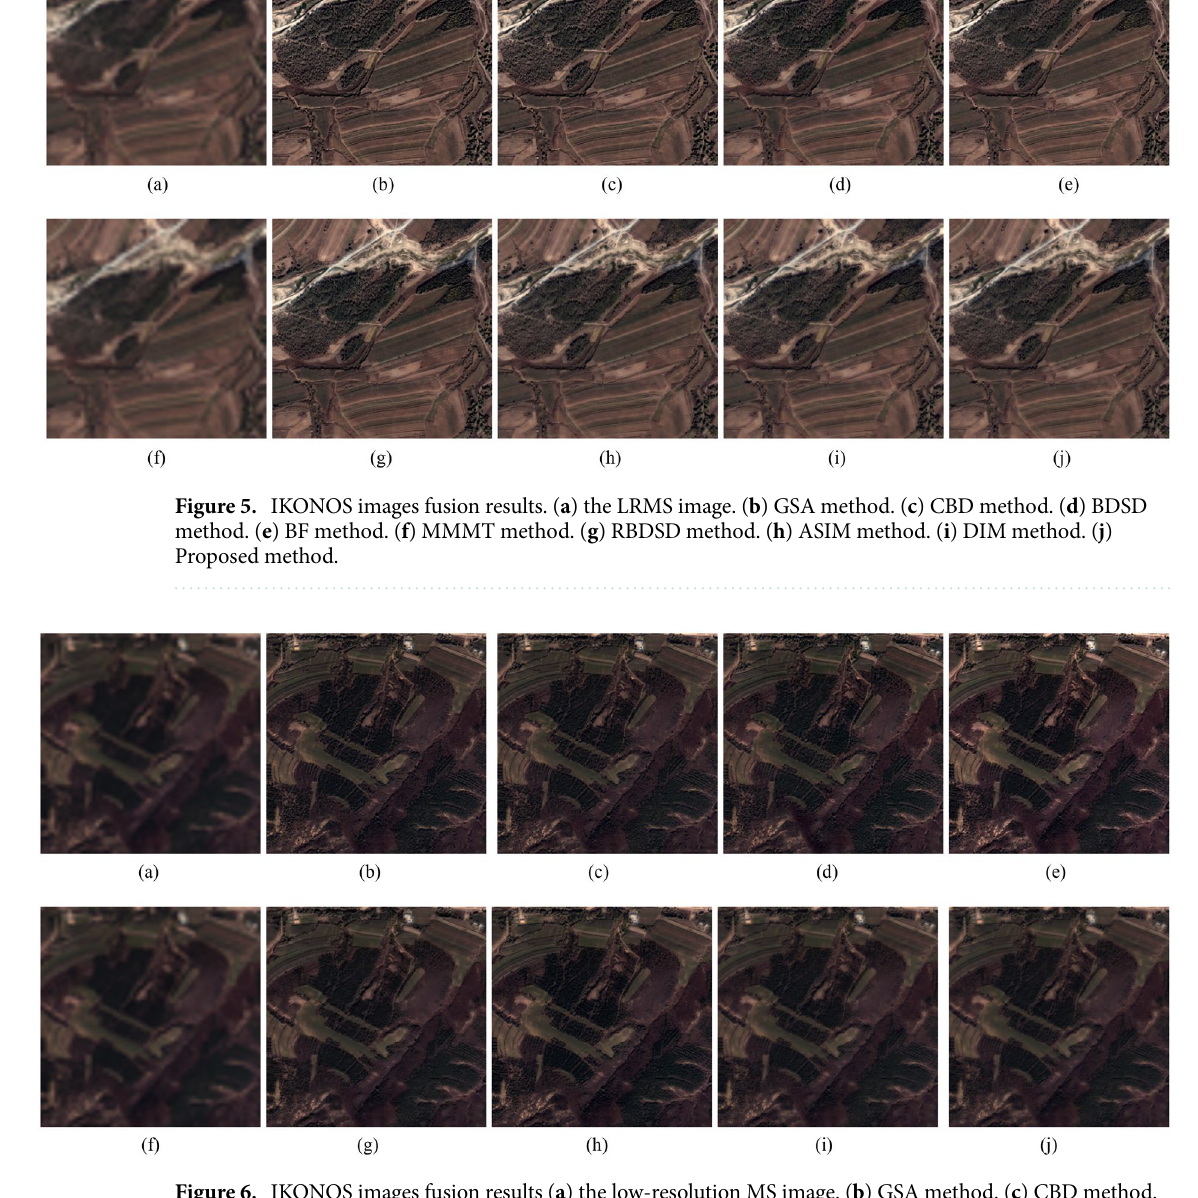
Figure 6. IKONOS images fusion results ( a ) the low-resolution MS image. ( b ) GSA method. ( c ) CBD method. ( d ) BDSD method. ( e ) BF method. ( f ) MMMT method. ( g ) RBDSD method. ( h ) ASIM method. ( i ) DIM method. ( j ) Proposed